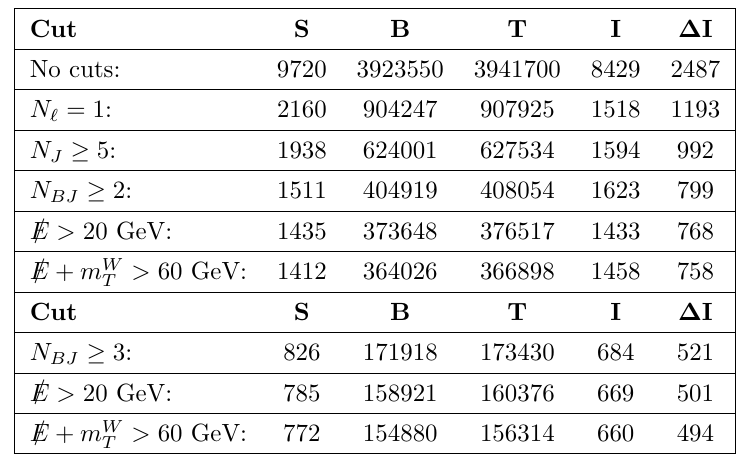
Cut (cid:13)ow results presented in expected event yield with 300 fb (cid:0) 1 of luminosity for the hMSSM benchmark with 5,000,000 events for each sample.